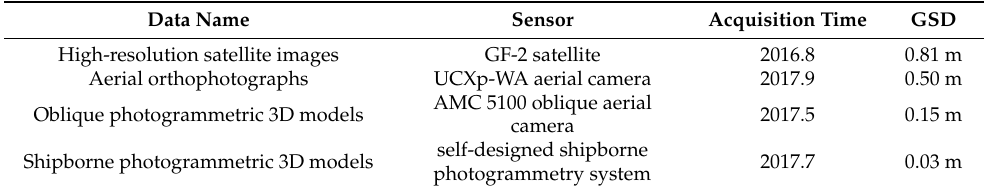
Table 3. Characteristics of the remote sensing data used for landslide detection ability assessment.